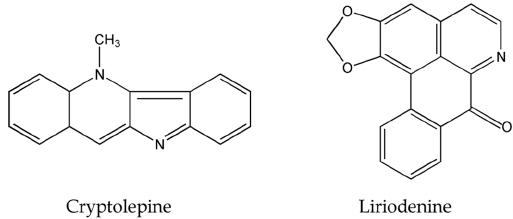
Figure 2. Chemical structures of scutebarbatine A, tabernaelegantinine B, tabernaelegantine C, brucine, isogravacridone chlorine, clausenidin, cryptolepine and liriodenine.